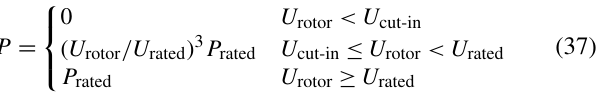
11.4 ms − 1 , and a rated power of 5 MW. The power curve